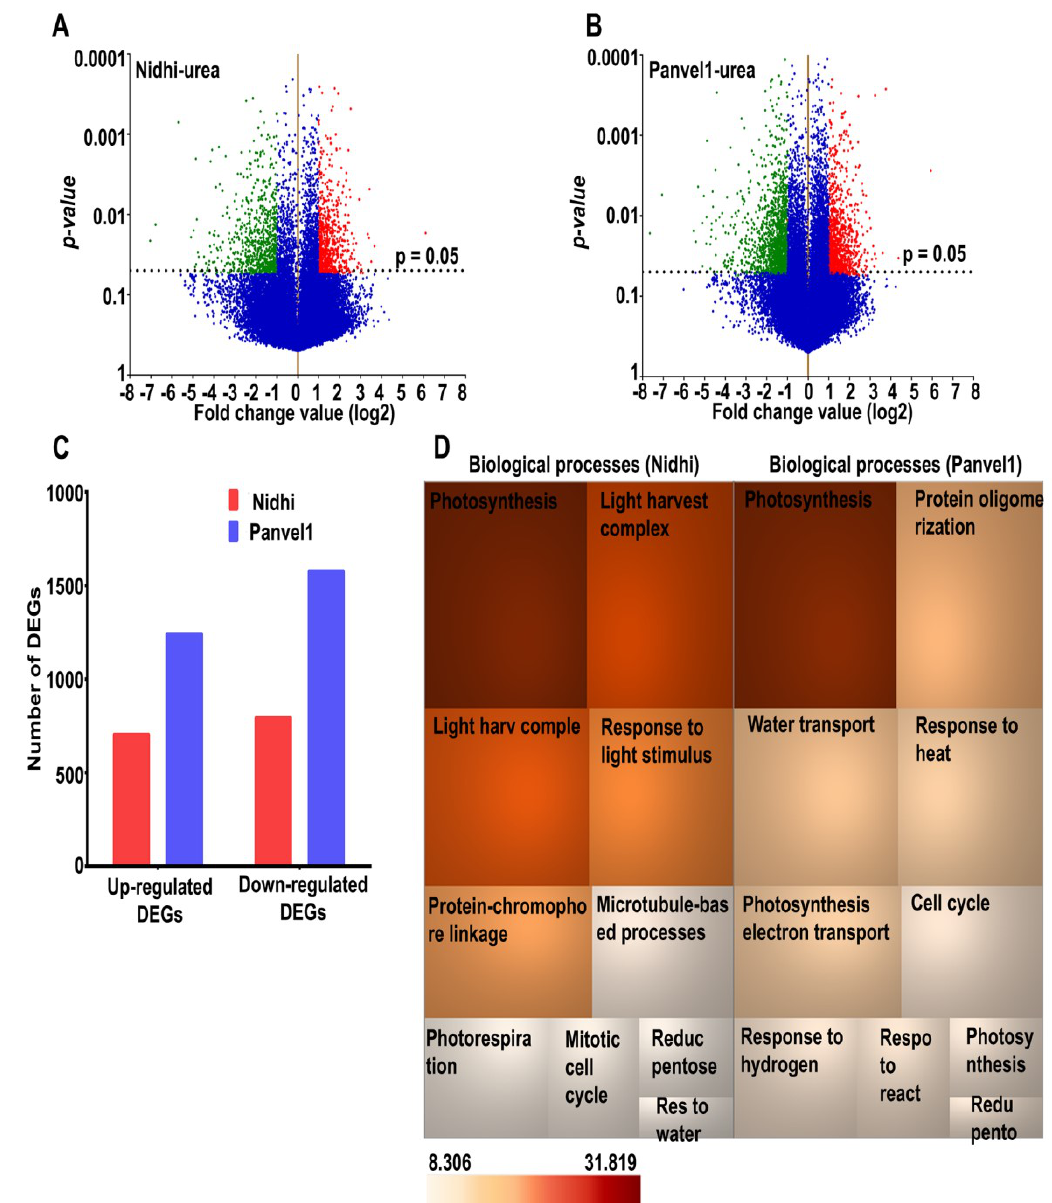
Figure 1. Transcriptomic analyses of low urea response in contrasting NUE genotypes. Nidhi and Panvel1 indica rice genotypes were grown in nutrient depleted soil in greenhouse under normal (15 mM) and low (1.5 mM) urea conditions [10]. Urea-responsive differentially expressed transcripts are shown as volcano plots for Nidhi ( A ) and Panvel1 ( B ). Each dot on the plot represents the transcript and horizontal dashed line corresponds to p value cut − off ( p = 0.05). Up-regulated transcripts are shown as red scattered dots, whereas green scattered dots represent down-regulated transcripts under low − urea treatment. ( C ) Bar graph represents the up − or down − regulated genes detected in Nidhi and Panvel1. ( D ) TreeMap shows top 10 statistically significant biological processes ( p < 0.05) observed in Nidhi and Panvel1. The colour of the box is according to the p value ( − log 2